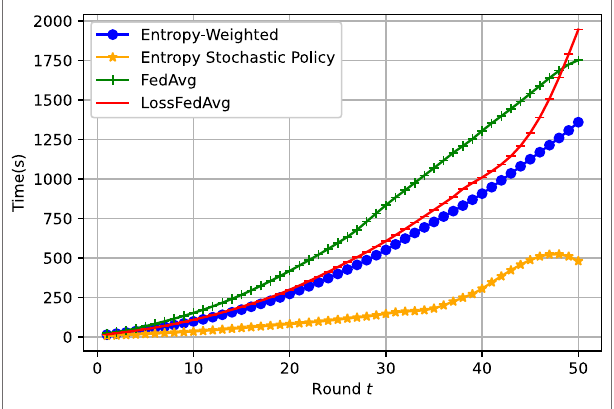
FIGURE 7 | Models time convergence for η (cid:1) 0.001.